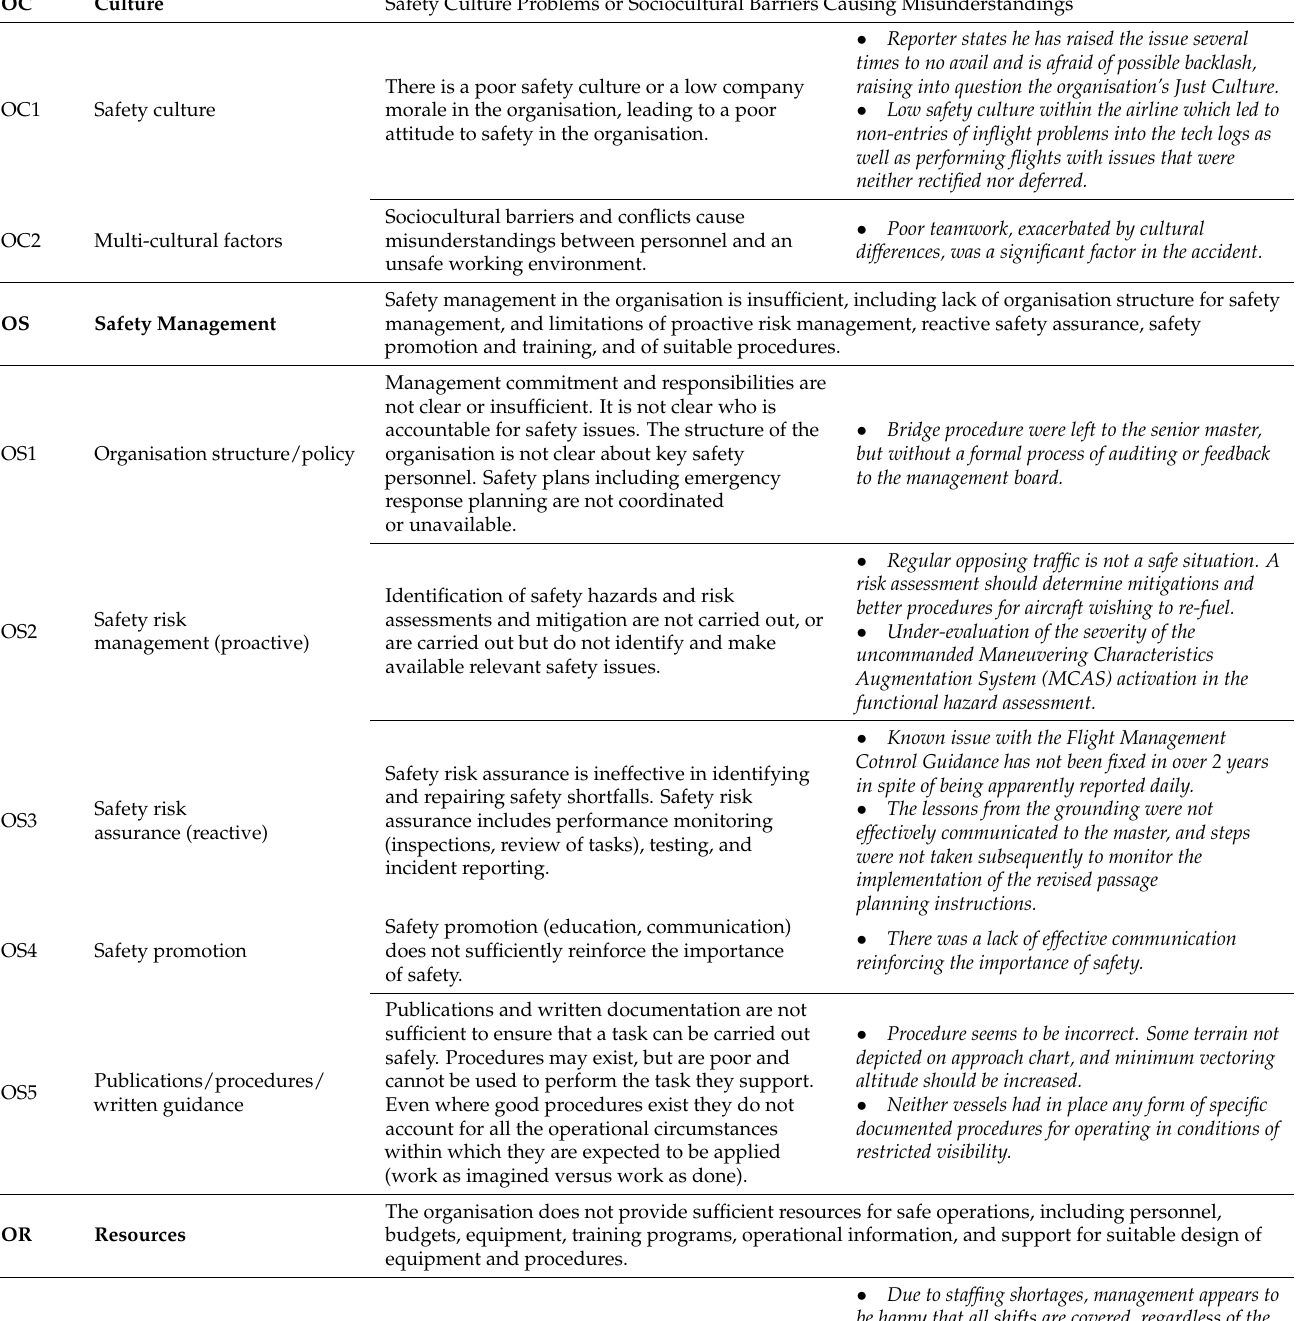
Table A4. Codes, titles, definitions, and guidance and examples of categories and factors in the Organisation